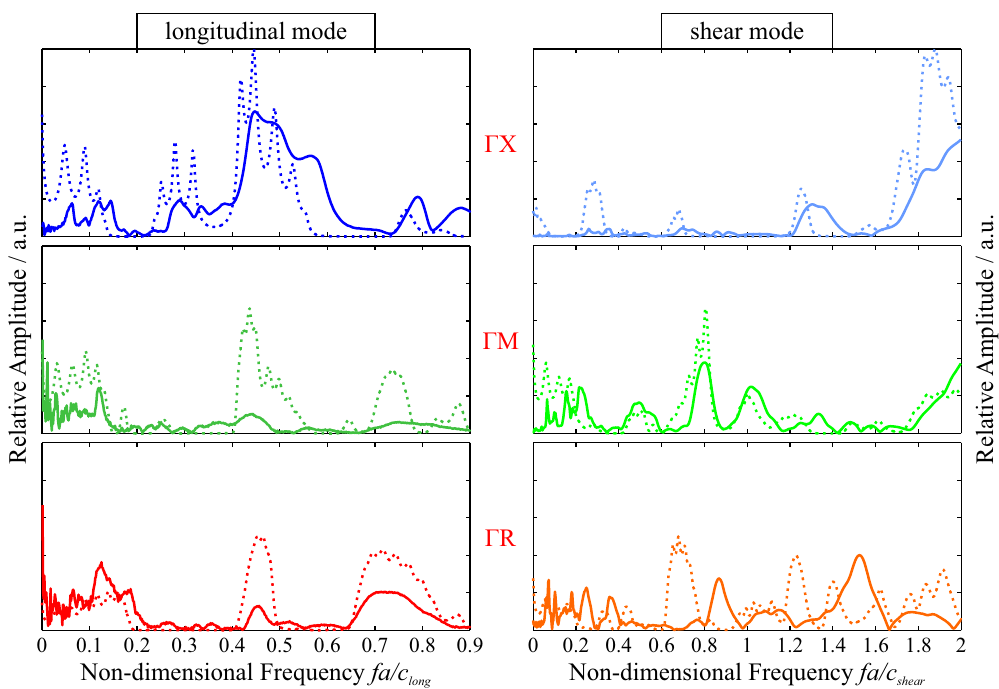
Figure 9. Normalized acoustic transmission for rectangular scaffold design Figure 1b in characteristic directions Γ X, Γ M, and Γ R for longitudinal waves and shear waves. Dotted lines indicate simulated transmission through a semi-infinite lattice.